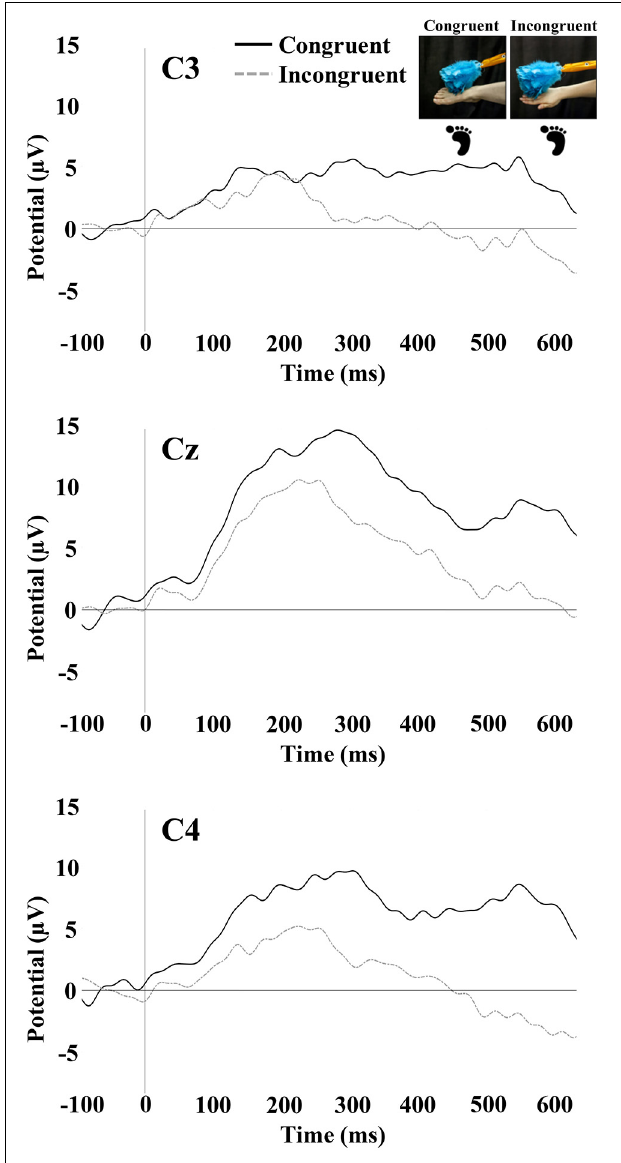
FIGURE 4 | SEP responses to tactile stimulation of the infant’s right foot. The plots display responses at central electrode sites C3, Cz, and C4. Foot icons indicate the infant body part receiving tactile stimulation. The photographs depict the live visual event observed by the